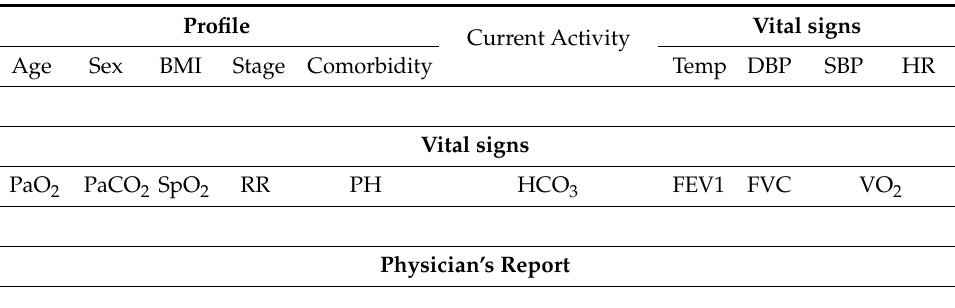
Table 13. Patient evaluation